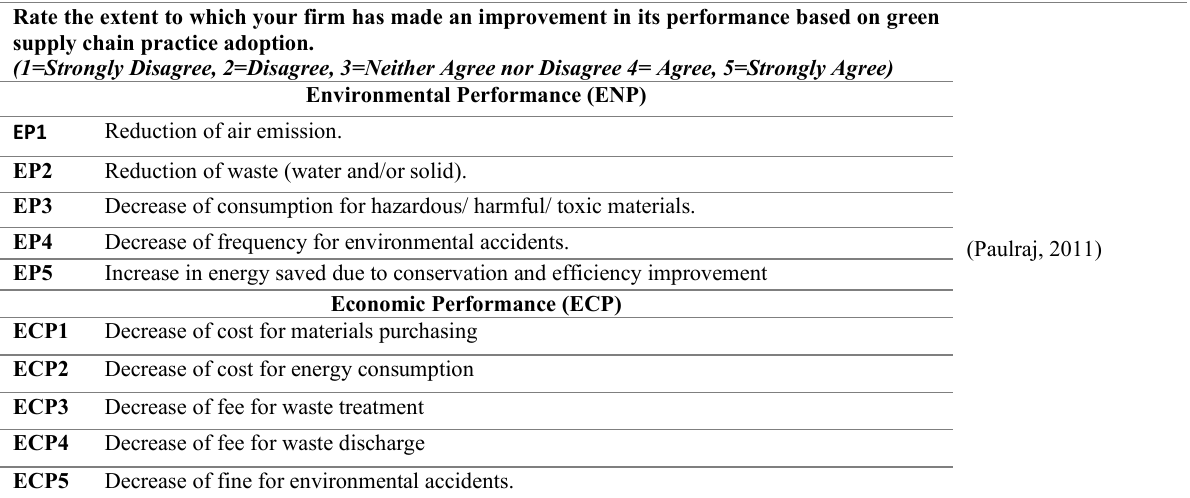
Firm Performance Source Rate the extent to which your firm has made an improvement in its performance based on green supply chain practice